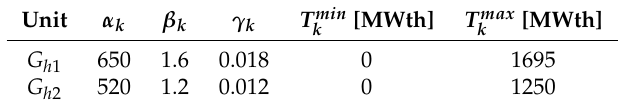
Table A3. The operation cost function parameters and output limit parameters of heat-only units.